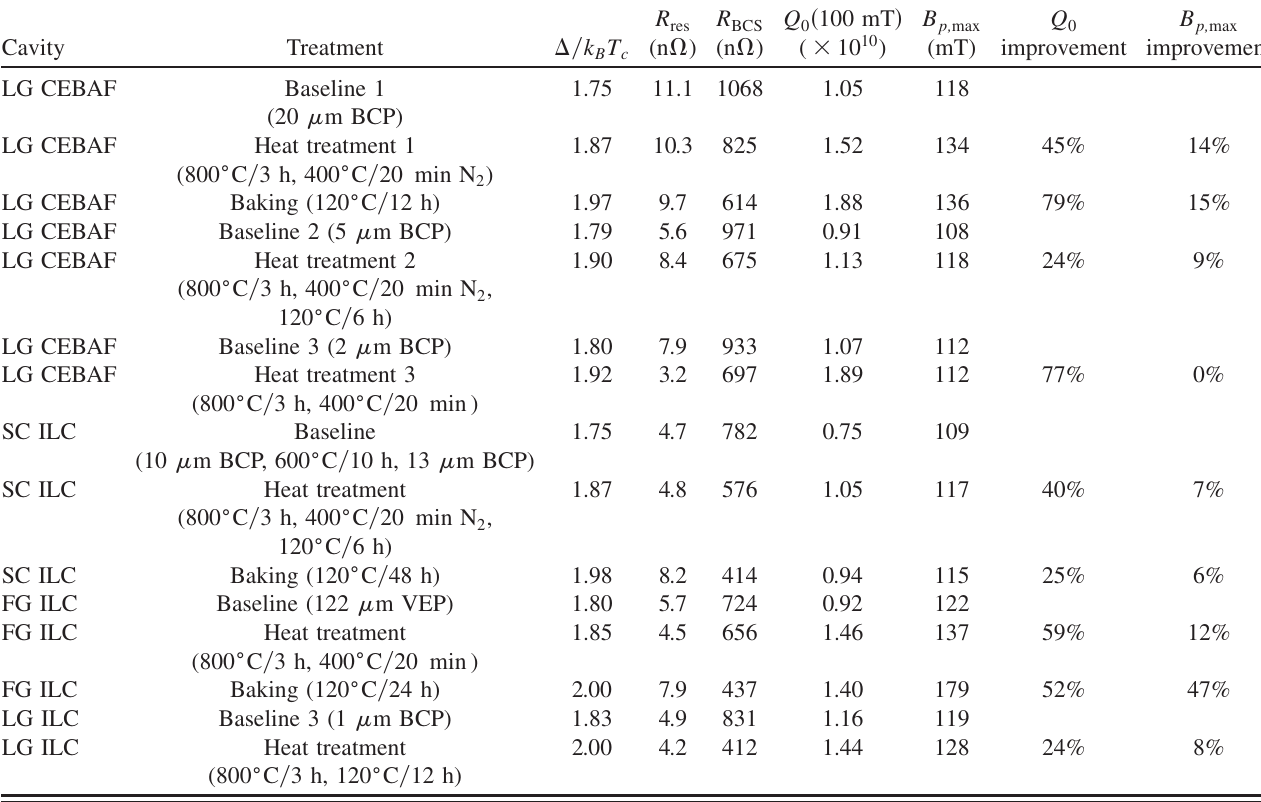
TABLE III. Values of (cid:2) =k over the baseline test for all the cavities and rf tests described in Secs. VA 1–VA 4.